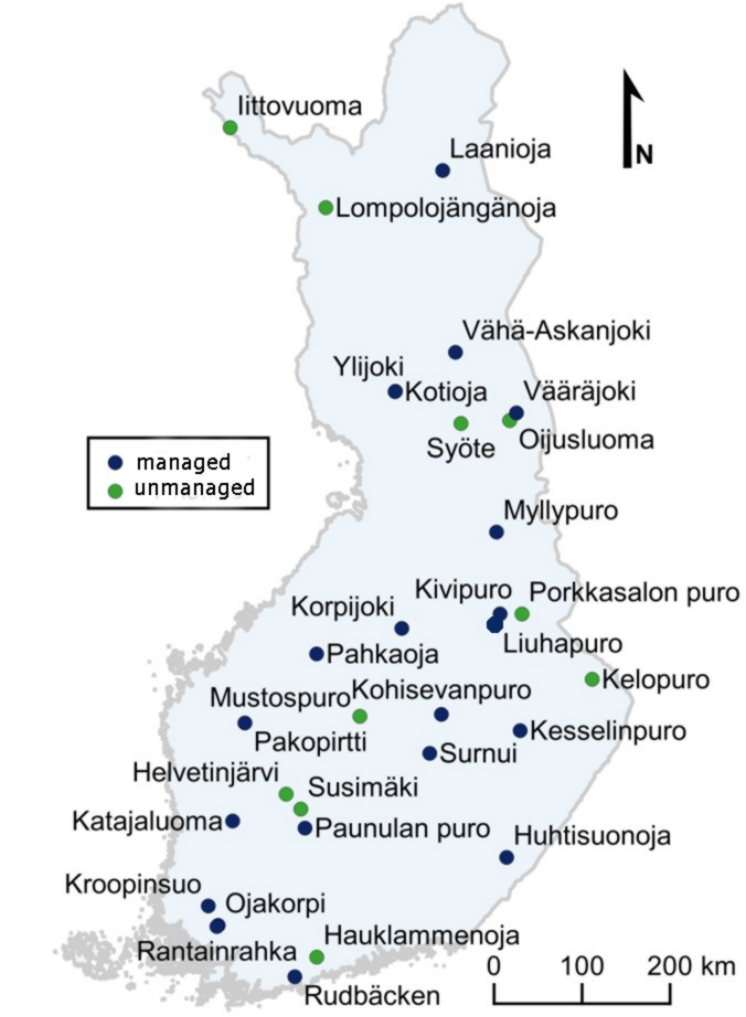
Figure 1. Study catchments containing 10 unmanaged and 20 managed headwater forest